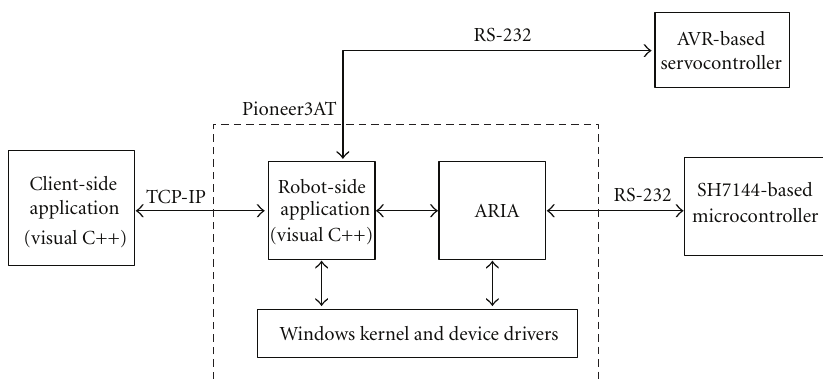
Figure 4: The overall software architecture of the robotic